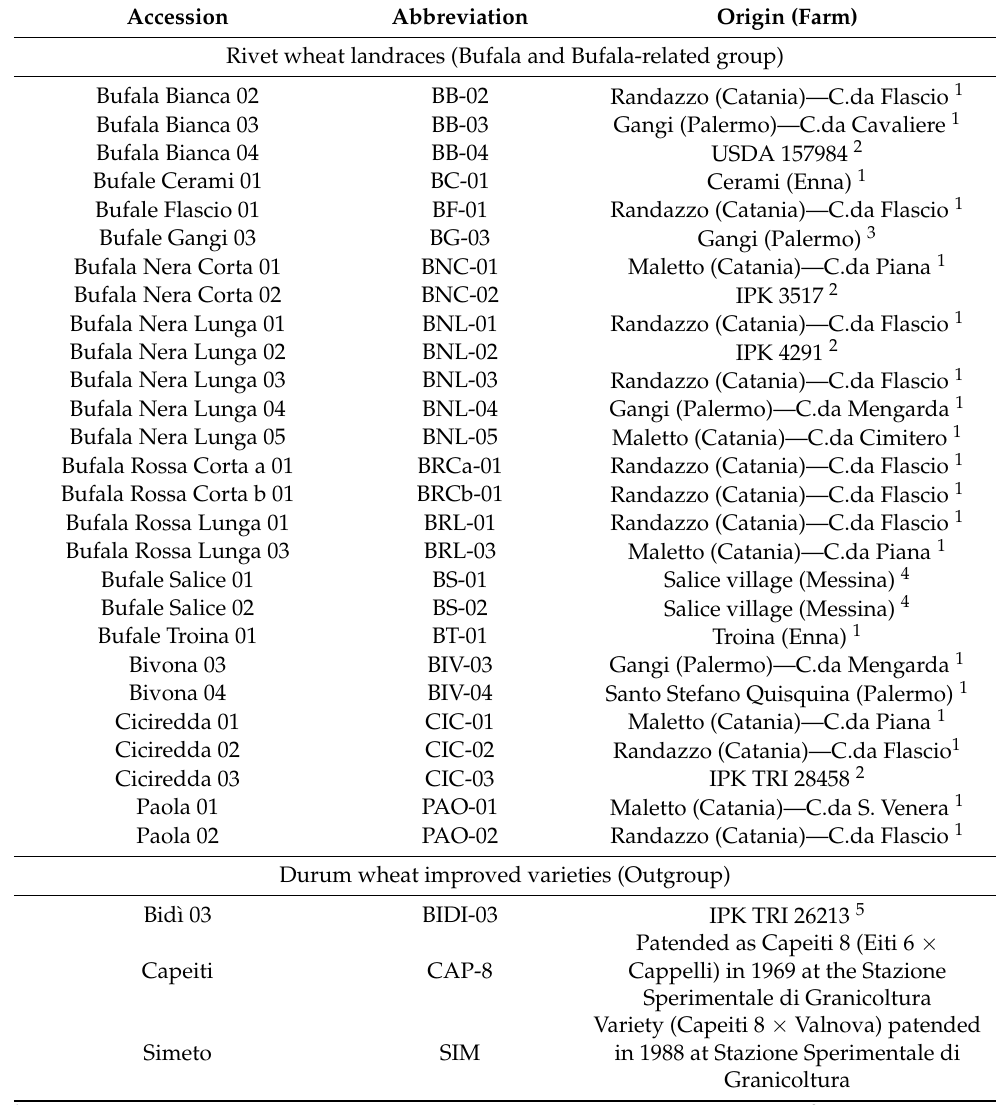
Table 1. List of accessions and their origin.